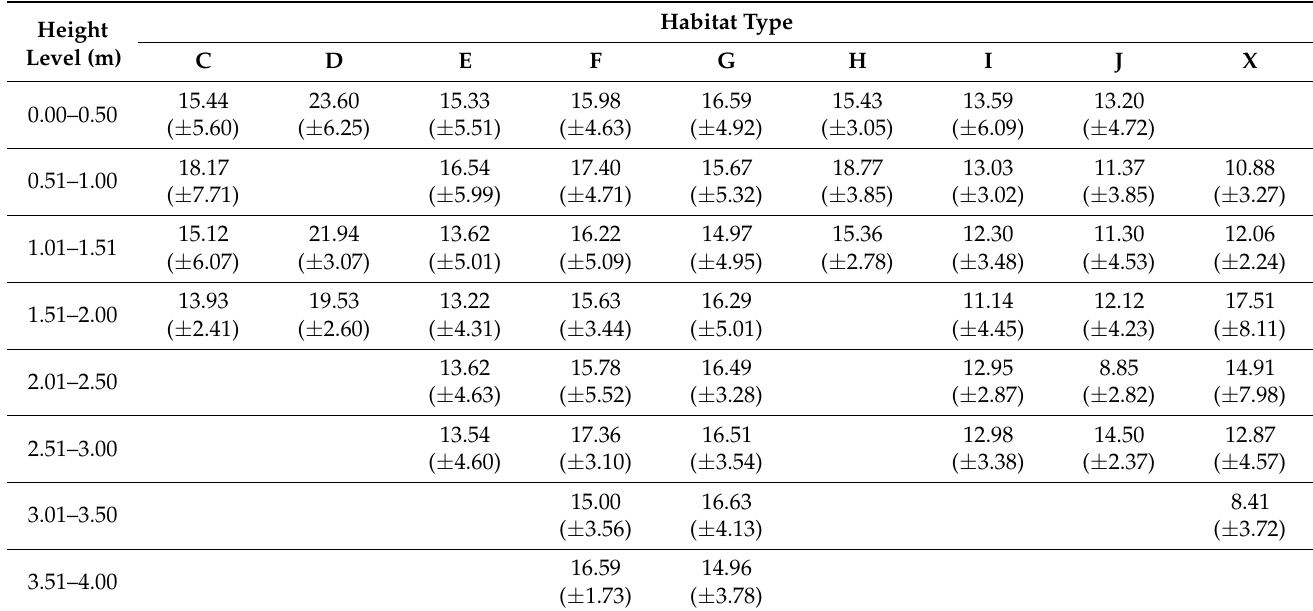
Table 8. The fresh weight (g) of the fruits (mean ± SD) of Echinocystis lobata at different height levels in inland surface waters (C); mires, bogs, and fens (D); grasslands and lands dominated by forbs, mosses, or lichens (E); heathland, scrub, and tundra (F); woodland, forest, and other wooded land (G); inland unvegetated or sparsely vegetated habitats (H); regularly or recently cultivated agricultural, horticultural and domestic habitats (I); constructed, industrial, and other artificial habitats (J); habitat complexes